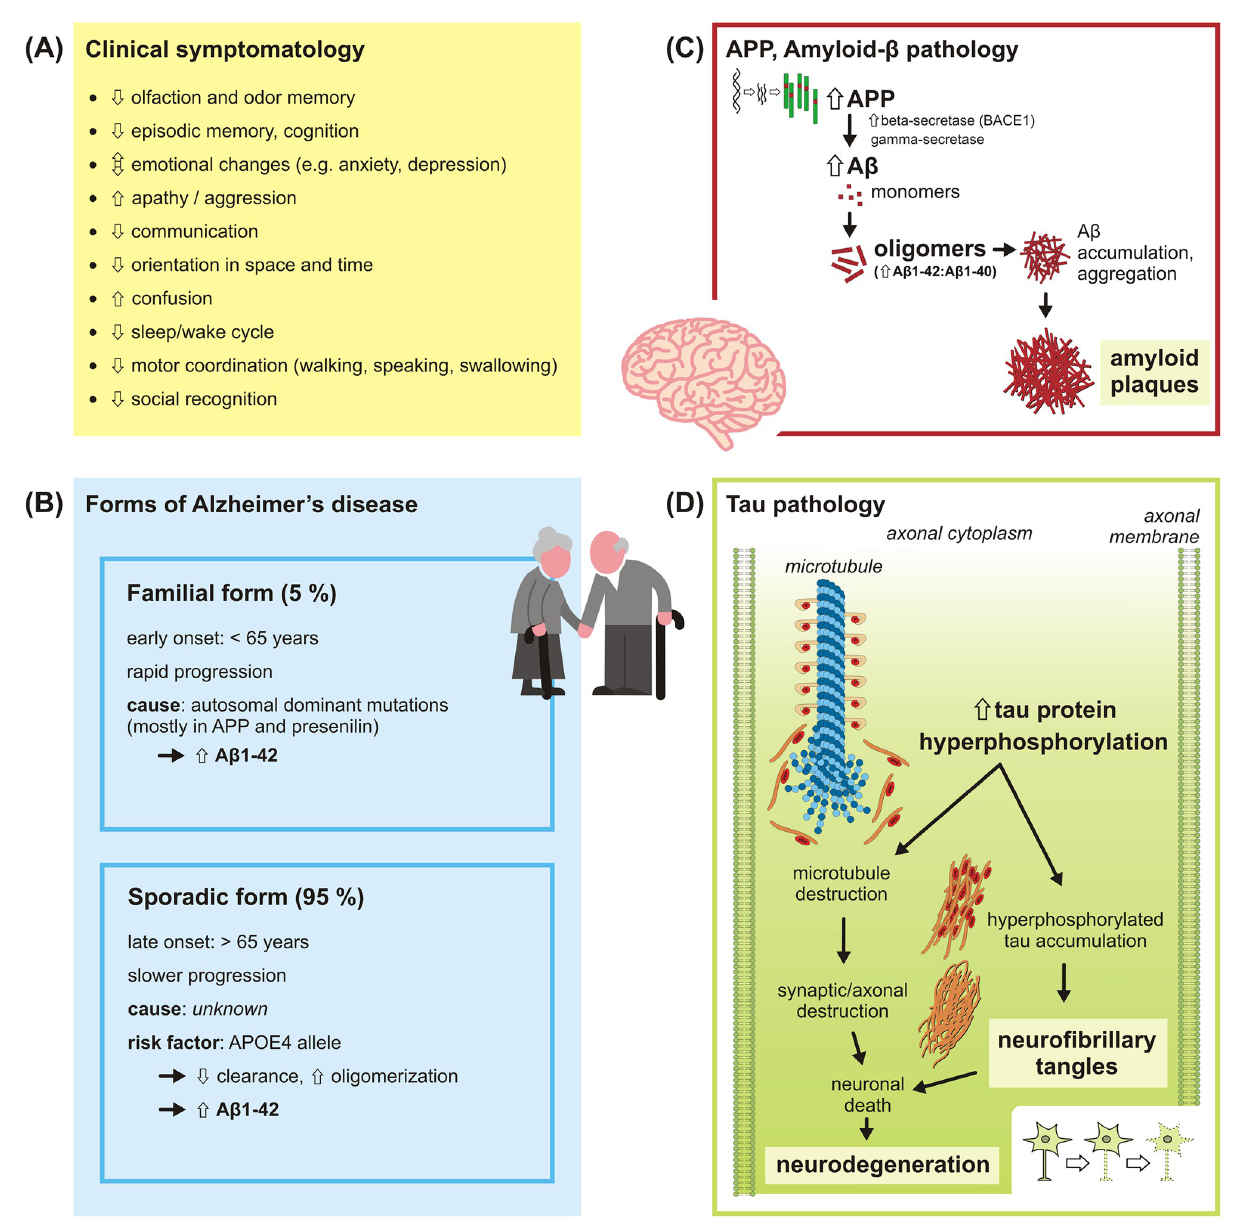
Fig 1. AD: Clinical symptomatology, forms, and A β and tau protein pathologies. (A) AD clinical symptomatology. The “down” arrows represent impairment or disruption of the brain functions in AD patients while “up” arrows symbolize the increase. (B) Two AD forms, familial and sporadic, differing in time of the onset, progression rate, and a cause, can be recognized. The familial form is associated with autosomal dominant mutations leading to inherently increased production of A β , especially the highly fibrillogenic A β ending at residue 42, (A β 1–42). By contrast, the sporadic form does not follow mendelian inheritance and its causative triggers remain unknown. The strongest known genetic factor is APOE4. (C) In AD, the monomers of A β , which are cleavage fragments of APP, aggregate into oligomers. The oligomers, especially the cytoplasmic ones, are believed to be the most toxic, although extracellular amyloid plaques are the most conspicuous outcome of the process. (D) The tau protein normally binds to and stabilizes microtubules within neuronal axons. In an AD patient brain, tau protein is hyperphosphorylated and accumulates into neurofibrillary tangles, which leads to destabilization of cytoskeleton, disruption of synapses, and finally death of neurons. A β , amyloid beta; AD, Alzheimer’s disease; APOE4, apolipoprotein E4 allele; APP, amyloid precursor protein; BACE1, beta-site APP-cleaving enzyme.